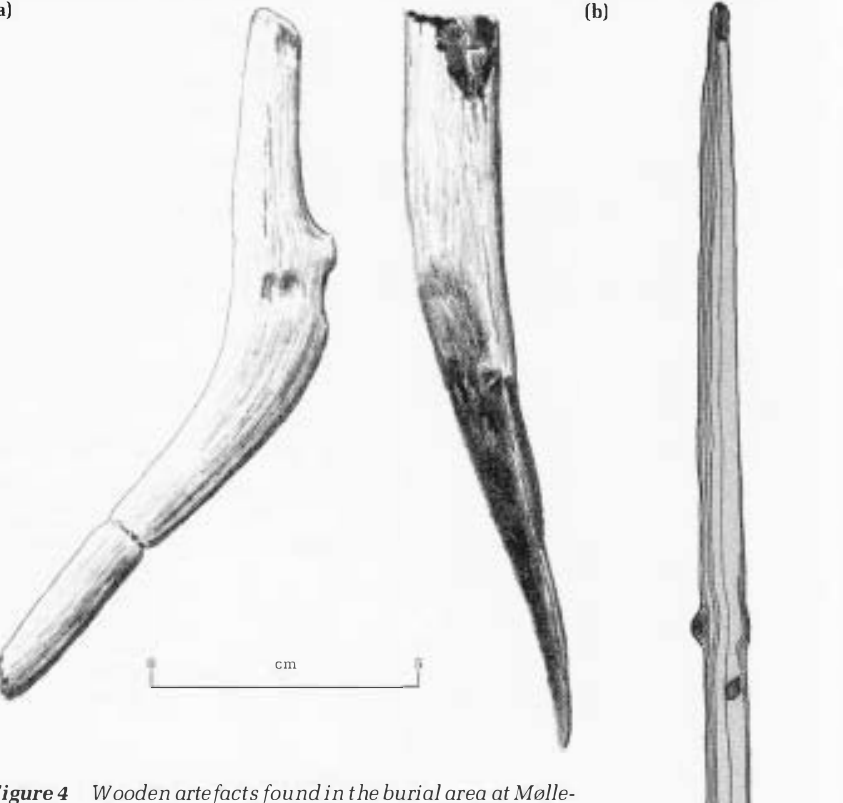
Figure 4 Wooden artefacts found in the burial area at Molle­ gabet II: (a) prongs of an eel spear, (b) a miniature bow made from a branch of red cornel (dogwood) (Thelycrania san­ guinea), perhaps used as a drill for boring holes or making fire.